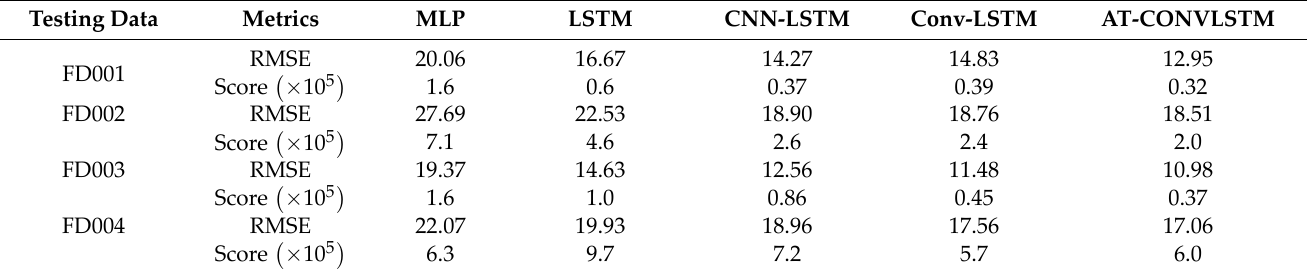
Table 3. Comparison of the average error between the proposed algorithm and other